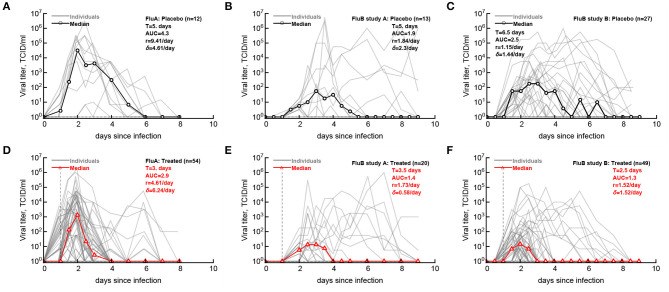
Commonly reported median viral shedding curves do not accurately represent shedding in many patients. We analyzed experimental data from 3 clinical trials of volunteers infected with influenza A (A,D) or influenza B (B,C,E,F) viruses and treated 24 h after viral exposure with placebo (A–C) or oseltamivir (D–F); start of treatment is indicated by the vertical dashed lines. Viral shedding in individual volunteers is shown by gray lines and median viral titers are shown by thick red lines with markers. For median viral titers we also calculated the duration of infection (T), the rate of viral growth (r) and viral decay (δ), and the total area under the curve (AUC, Equation 1). Details of the experiments and basic viral characteristics calculated are given in [Hayden et al. (1999, 2000) see Figure 1]. The limit of detection is represented by the horizontal thin dashed line; the detection limit was 0 log10TCID50/ml for all data. Viral shedding curves in individual volunteers are shown in Supplementary Figures 1–9.